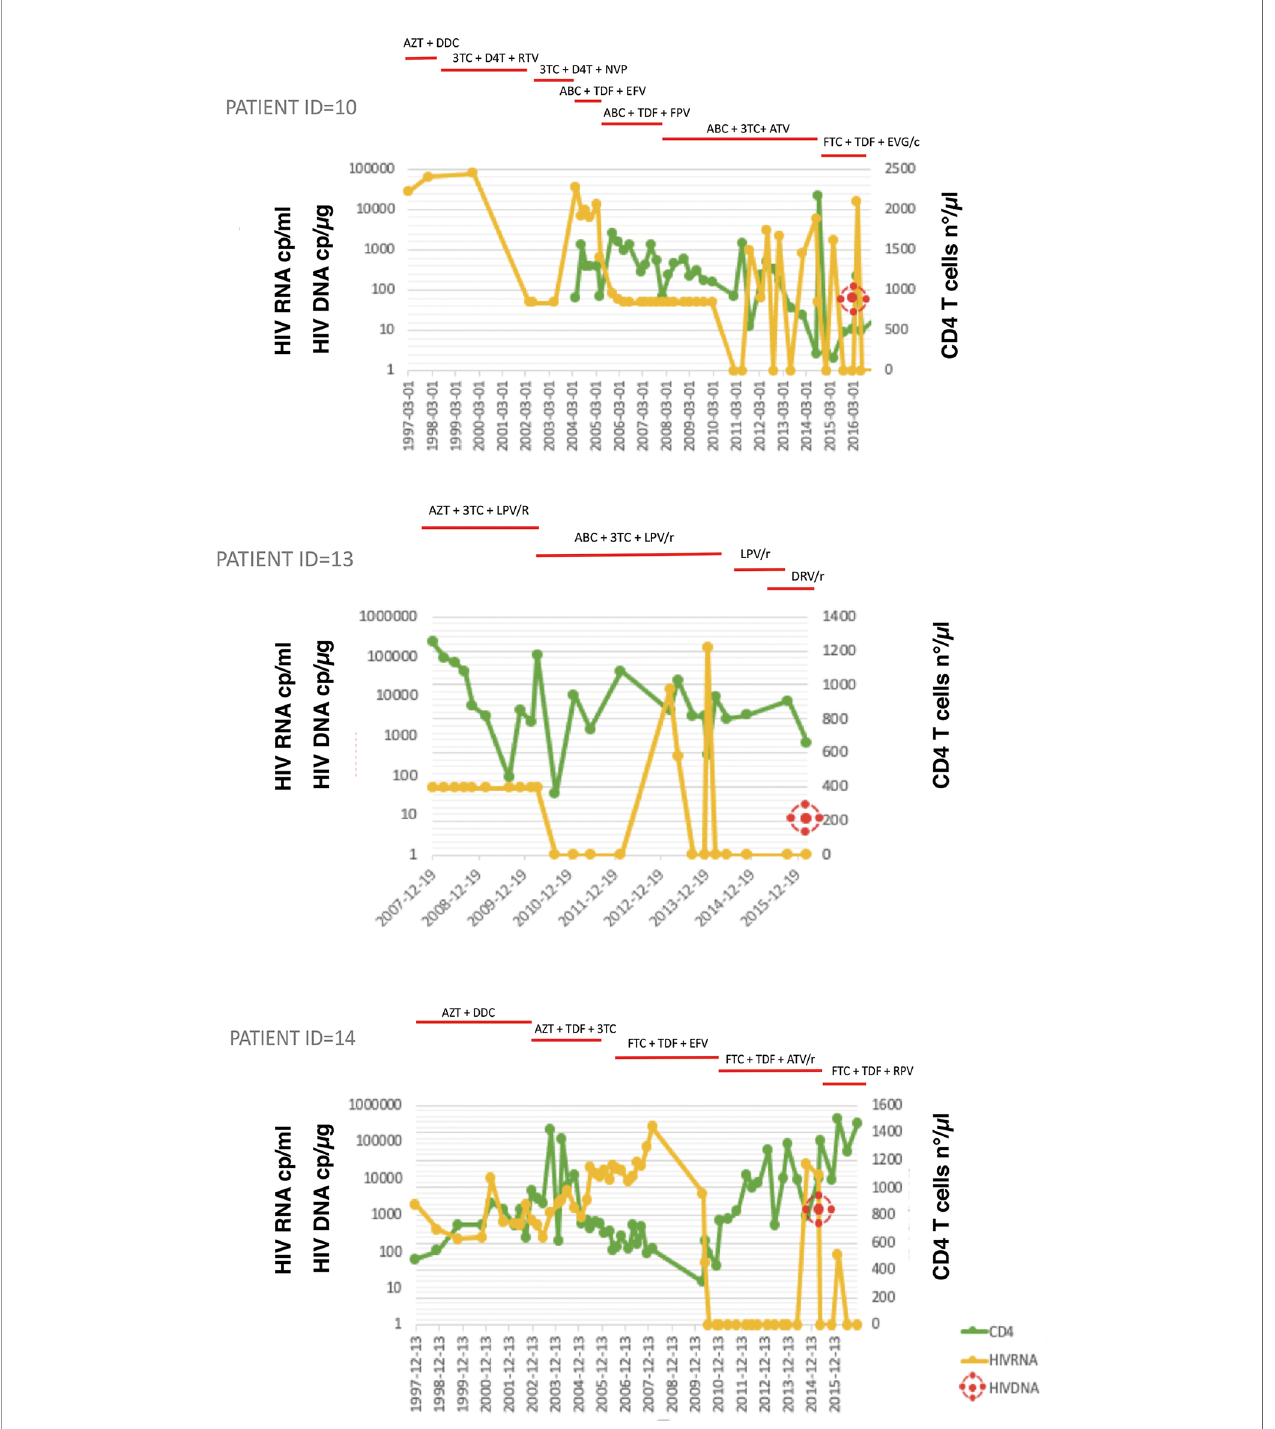
FIGURE 1 | HIV-RNA and CD4+ T-cell count (CD4) trends over the years and total HIV DNA at study time in three representative patients. Treatments are shown on the top, bars indicate start and stop of relative antiretroviral medication. 3TC, lamivudine; ABC, abacavir; ATV, atazanavir; AZT, zidovudine; D4T, stavudine; DDC, zalcitabine; EFV, efavirenz; EVG/c, elvitegravir/cobicistat; FTC, emtricitabine; FPV, fosamprenavir; TDF, tenofovir disoproxil fumarate; NVP, nevirapine; RTV, ritonavir Top panel, Patient ID=10: multiple virological failures over the years due to low adherence to antiretroviral therapy (ART); Middle panel, patient ID=13: successfully treated from birth while maintaining good adherence to ART; Bottom panel, patient ID=14: treated late after birth, although with very good adherence to ART over the